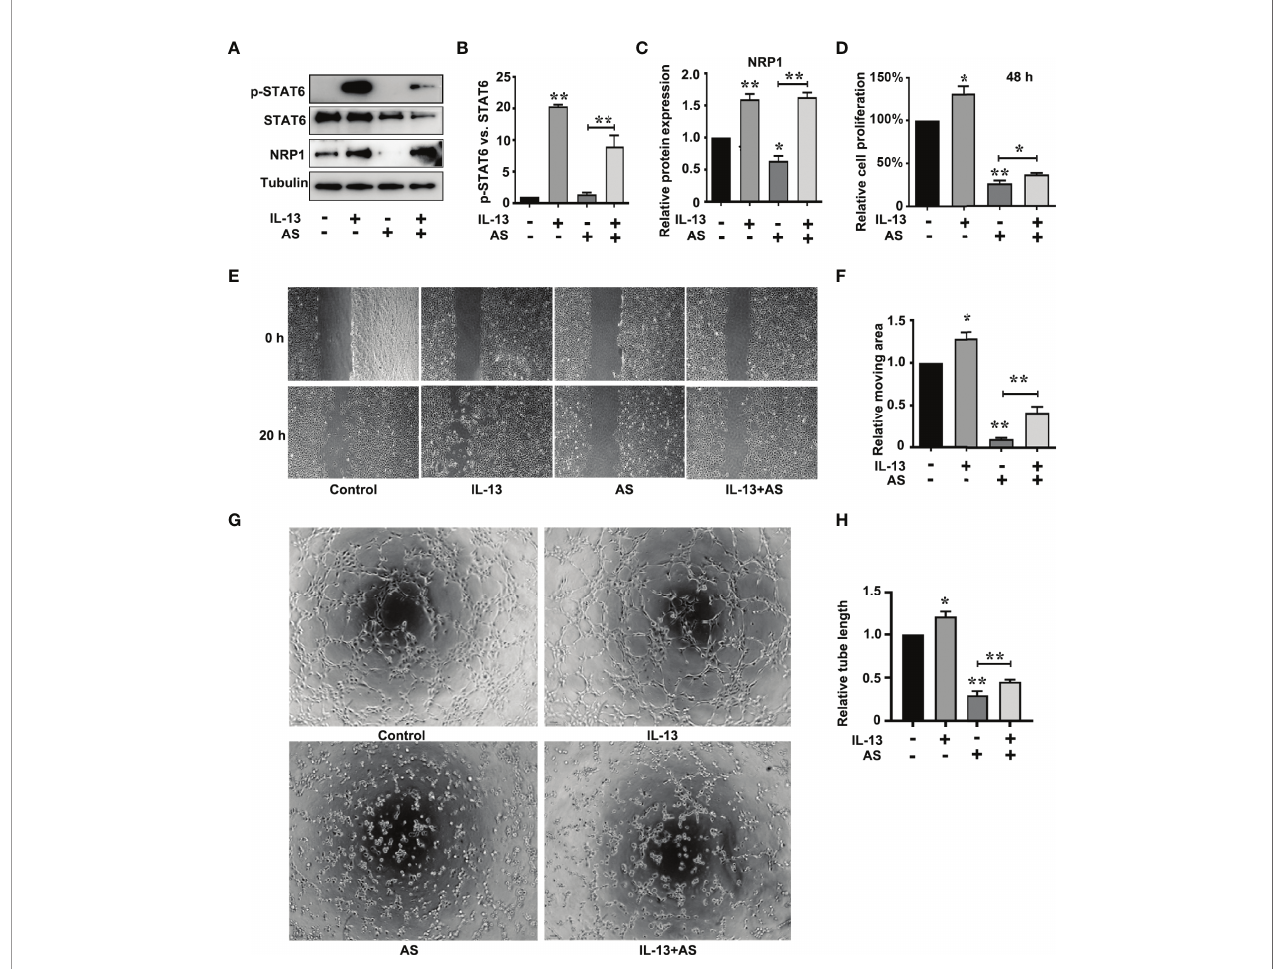
FIGURE 4 | STAT6-mediated NRP1 expression and promotes migration, proliferation, and tube-formation in HUVECs. (A) Phosphorylation of STAT6, STAT6, and NRP1 were detected by western blotting in HUVECs treated with AS (1 m M), IL-13 (50 ng/mL), and AS combined with IL-13 for 24 (h) (B) Relative STAT6 phosphorylation level was normalized with STAT6, n=3, ** P <0.01 vs. control. (C) Relative NRP1 expression normalized with tubulin after AS and IL-13 treatment, n=3, * P <0.05 vs. control, ** P <0.01 vs. control. (D) The relative cell proliferation was detected by MTT in HUVECs treated with AS (1 m M), IL-13 (50 ng/mL), and AS combined with IL-13 for 48 h, n=5, * P <0.05 vs. control, ** P <0.01 vs. control. (E, F) The typical images and the relative moving area of HUVECs treated with AS (1 m M), IL-13 (50 ng/mL), and AS combined with IL-13 for 20 h, n=5, * P <0.05 vs. control, ** P <0.01 vs. control. (G, H) Typical images and relative tube length of HUVECs treated with AS (1 m M), IL-13 (50 ng/mL), and AS combined with IL-13 for 24 h, n=5, * P <0.05 vs. control, ** P <0.01 vs.